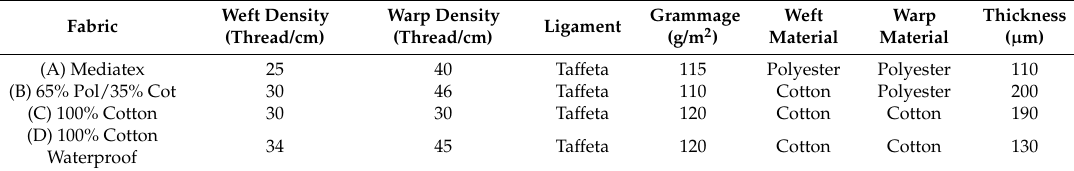
Figure A3. Cotton fibers without PEDOT:PSS ( a ) and after the screen printing of PEDOT:PSS ( b ). Table A1. Characteristics of the different fabrics used.